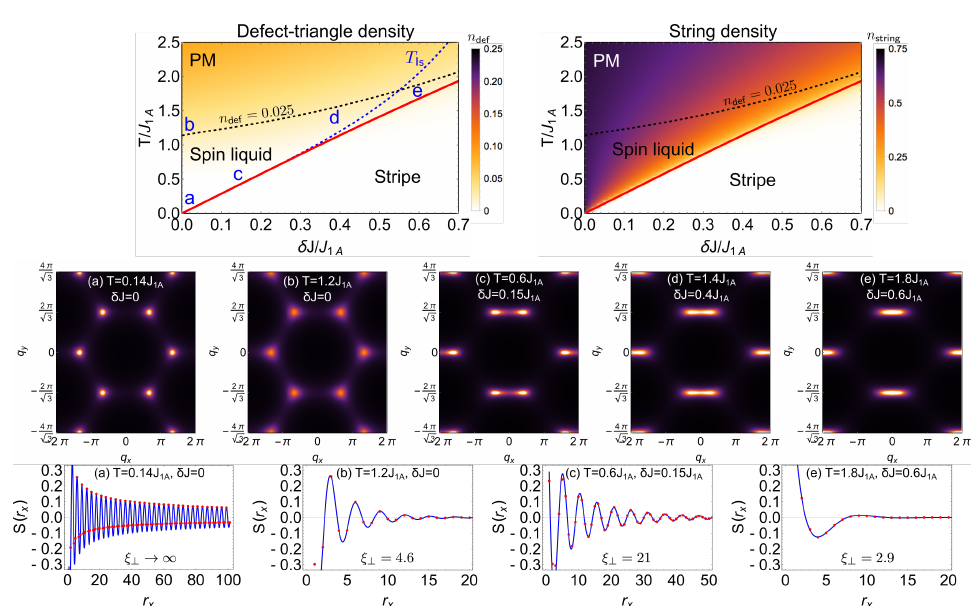
[ Eq. 32 ] in the unconstained manifold. Figure 22: The phase diagram and structure factor of H ABB (Top) Phase diagram showing stripe-ordered, spin-liquid and paramagnetic (PM) regions, with lines showing the critical temperature T c [ Eq. 61, red ] as well as T Is [ Eq. 62, blue dashed ] . Colour overlays show the density of defect triangles, n def , and string density, n string , calculated from the Grassmann path integral approach. (Middle) The structure factor S ( q ) calculated on an L = 72 hexagonal cluster using Monte Carlo simulation. (Bottom) The real space structure factor S ( r x ) [ Eq. 4 ] in the direction perpendicular to the strings (i.e. parallel to A bonds), calculated in the thermodynamic limit using the Grassmann path integral approach. The blue line shows a fit to the long-distance asymptotic form given in Eq. 64, with the fitting parameters ξ ⊥ , q x and a multiplicative prefactor. (a) At δ J = 0 and T (cid:28) J 1A the structure factor is indistinguishable from T = 0, with sharp essentially algebraic peaks at (cid:112) q = ( ± 2 π/ 3,2 π/ 3 ) and a correlation length ξ ⊥ → ∞ . (b) At δ J = 0 and T ∼ J 1A the peaks remain at (cid:112) q = ( ± 2 π/ 3,2 π/ 3 ) but broaden and the correlation length is only a few times larger than the lattice spacing. (c) For δ J (cid:28) J 1A and for temperatures deep in the spin-liquid regime there are a pair of peaks (cid:112) whose positions approximately track the string density according to q string ( T ) = ( ± π n string ,2 π/ 3 ) . The correlation length is typically many times the lattice spacing. (d) At δ J (cid:28) J 1A = 0.4 the spin-liquid (cid:112) 3 ) . (e) region is narrow, but weight at q string ( T ) remains more significant than that at q stripe = ( 0,2 π/ At δ J (cid:28) J 1A = 0.6 the spin-liquid regime has disappeared and above the transition the structure factor (cid:112) is dominated by correlations at the ordering vector, q stripe = ( 0,2 π/ 3 )